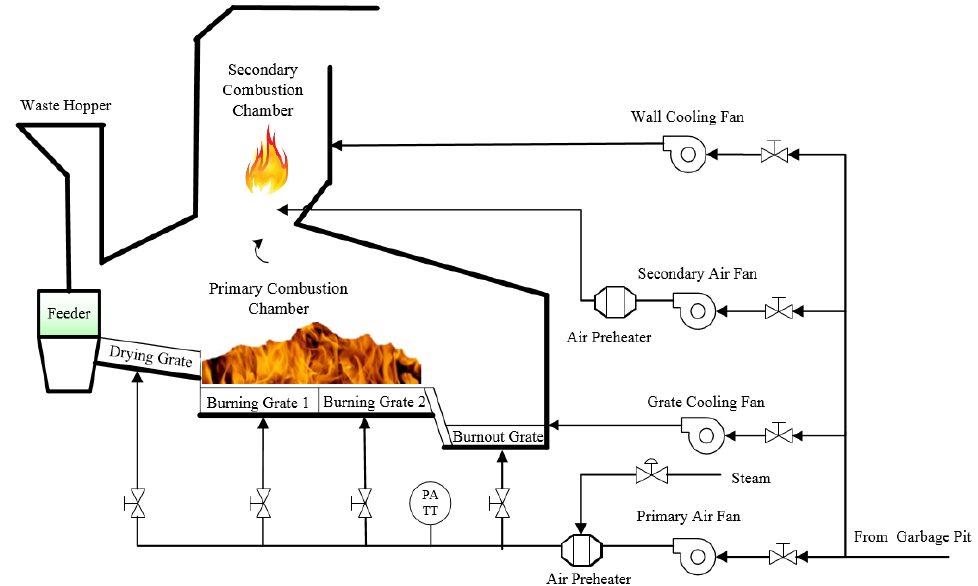
Figure 1. Flow chart of MSW incineration. Table 1. Details of Feature Variables.